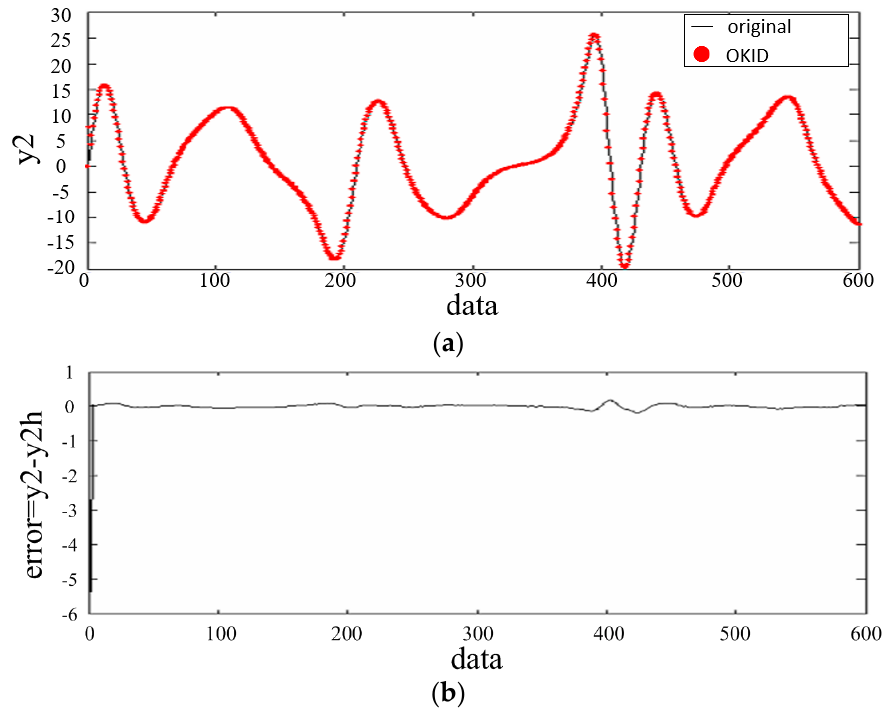
Figure 5. ( a ) Trajectories of y 2 ( t ) and ˆ y 2 ( t ) ; ( b ) Data of output error (cid:101) y 2 ( t )